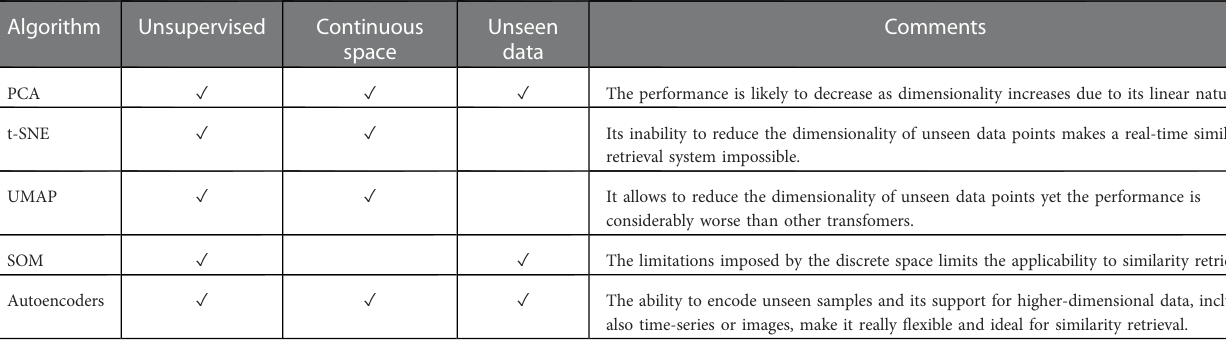
TABLE 3 Overview of dimensionality reduction